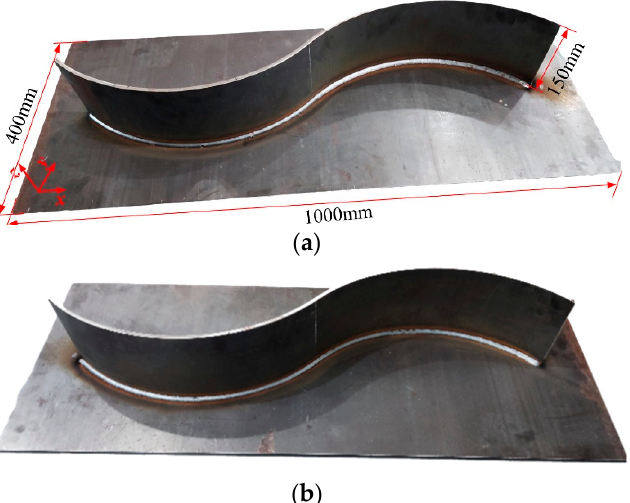
Figure 15. Welded product under the welding sequence “ ①②③④⑤⑥ ”: ( a ) front view; ( b ) reverse view.